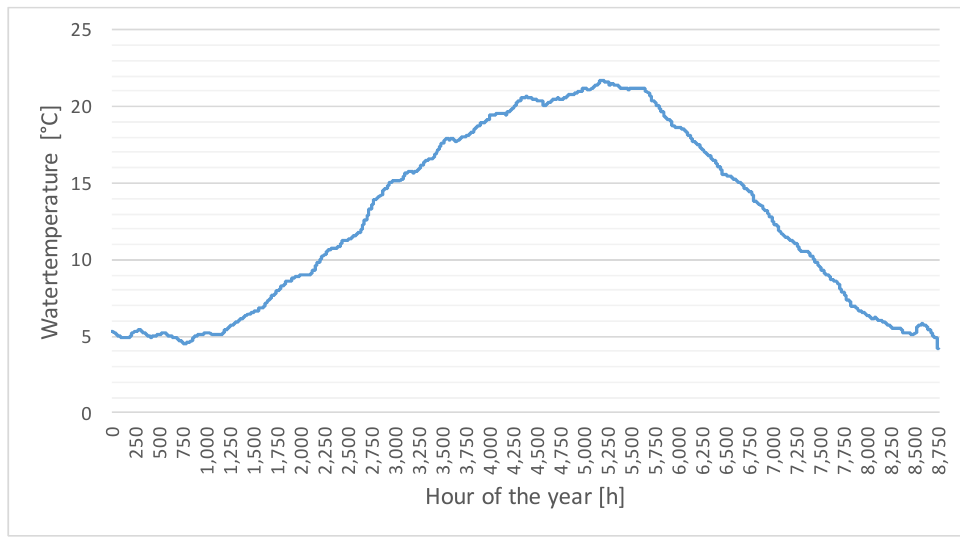
Figure 9. 26-year average water temperature of the river Neckar at Besigheim (data from